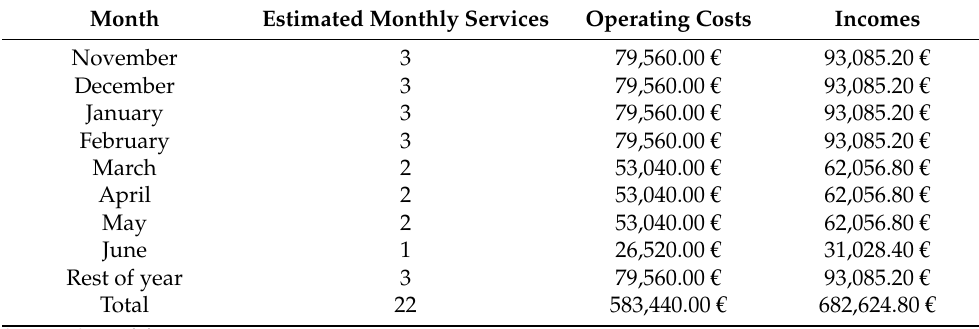
Table 14. Monthly estimate of services, with the operating expenses of those services and the income they